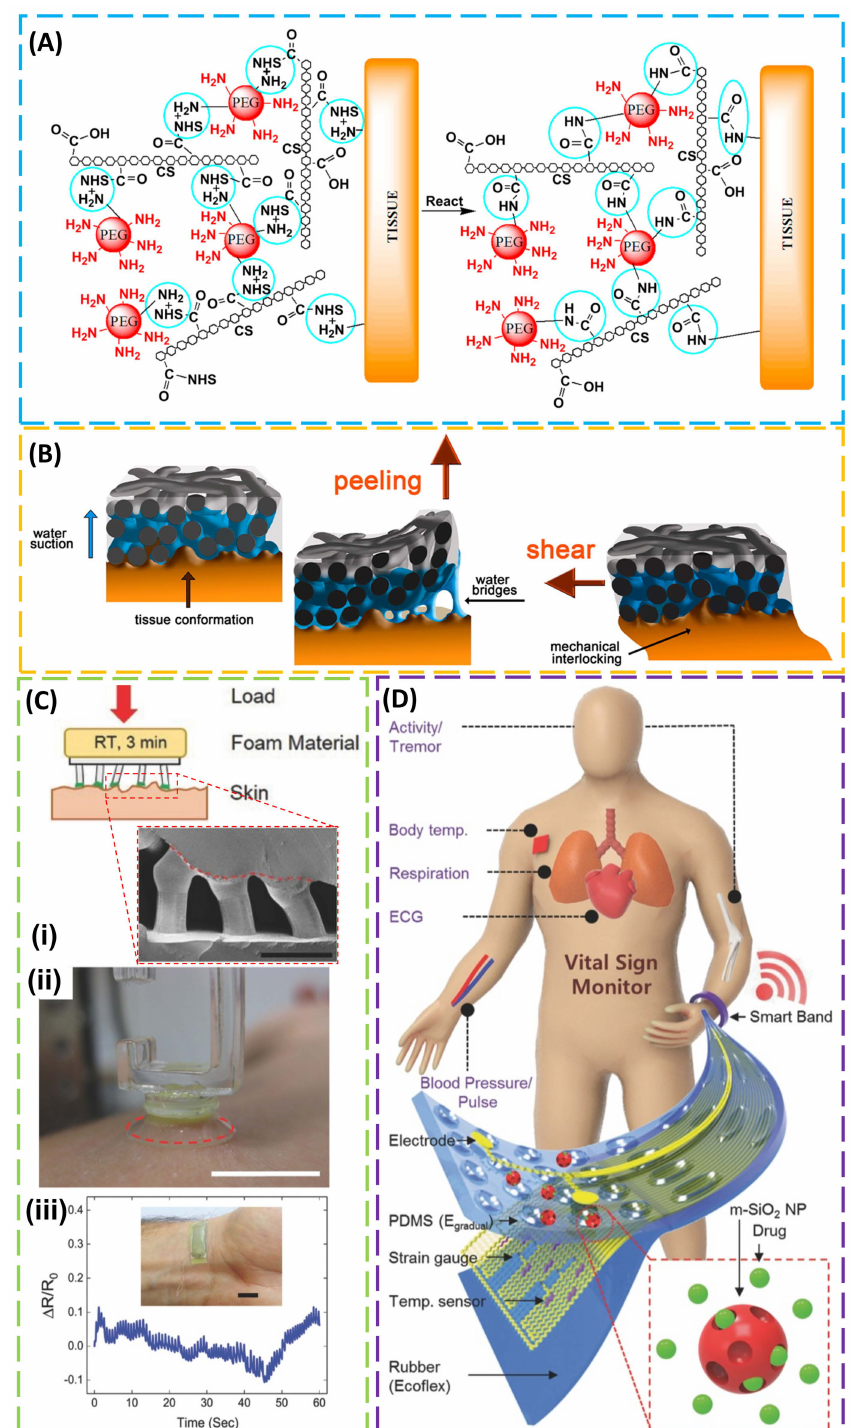
Figure 4. Adhesives on soft tissues. ( A ) Chondroitin sulfate N -succinimidyl succinate (CS–NHS) reacts with primary amines of both six-arm polyethylene glycol amine PEG–(NH 2 ) 6 and proteins of the tissue to form a covalently bonded hydrogel to the tissue. Reproduced with permission from Reference [115]; Copyright 2010, Elsevier. ( B ) When the buckypaper (BP) comes into contact with the wet biological tissue, water suction leads to deformation of the soft tissue and conformal contact of the BP to the